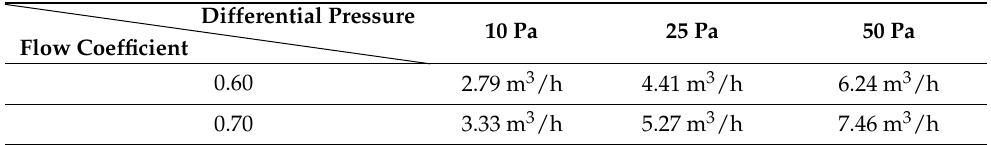
Table 1. Theoretically projected volume leakage